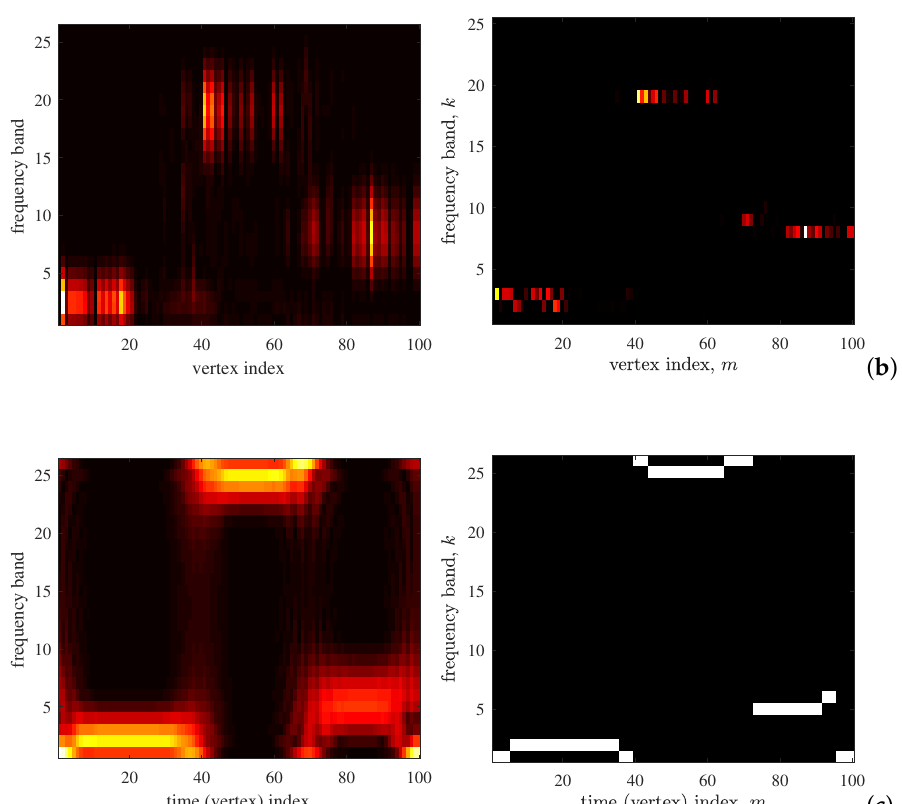
Figure 7. Time–frequency and vertex–frequency representations of the signals from Example 1: ( a ) Time–frequency analysis of the harmonic signal from Example 1, shown in Figure 3 (top), using the transfer functions from Figure 5 (bottom). ( b ) Vertex–frequency analysis of the general graph signal from Example 1, shown in Figure 3 (bottom), using the transfer functions from Figure 6 (bottom). ( c ) Time–frequency analysis of the harmonic complex signal from Example 1, using the transfer functions from Figure 5 (bottom). The complex signal is formed by adding two corresponding sine and cosine components. In all cases, the original representation is given on the left panel, while the reassigned value to the position of the distribution maximum is given on the right